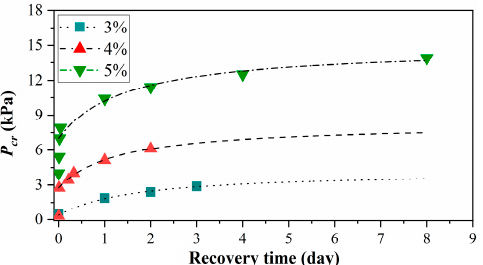
Figure 10. Relationship between cracking pressure P cr and recovery time. The P cr values near the origin of horizontal coordinates represent the elastic recovery, which become significant at high concentrations. And then all the curves are similar to the strength growth in the rest period and reach stable stages at the large recovery time.